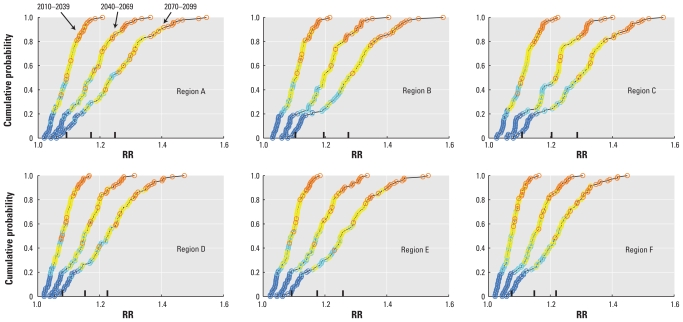
Projected changes of diarrhea with climate change. The projected changes to the RR of diarrhea, with respect to the 1961–1990 baseline, are shown as empirical cumulative distribution functions (ECDFs) for regions A–F. In each plot, all the values in the RR projection matrices are shown for three time periods: 2010–2039 to the left, 2040–2069 in the middle, and 2070–2099 to the right. The values are shown with distinct colors according to the corresponding α-values, that is, the empirically derived increases in the RR for each 1°C temperature increase. Blue colors correspond to α = 0.03, turquoise to α = 0.06, yellow to α = 0.08 and orange to α = 0.11.